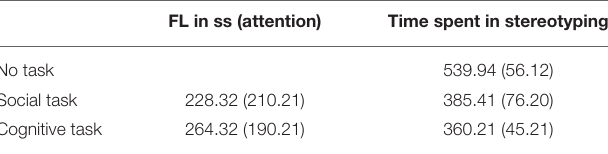
TABLE 2 | Means and (Standard deviations) of the seconds of behavioural indexes.